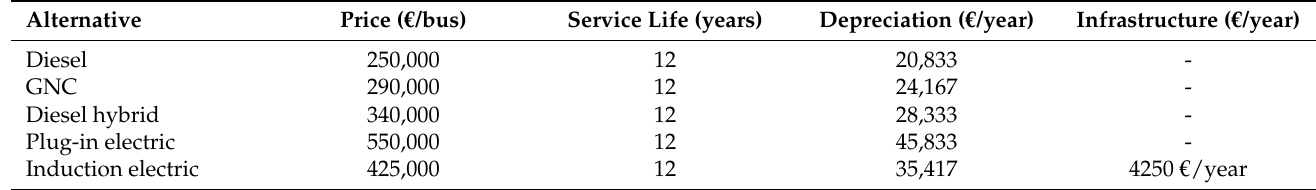
Table 7. Data for the analysis of depreciation costs by type of fuel.